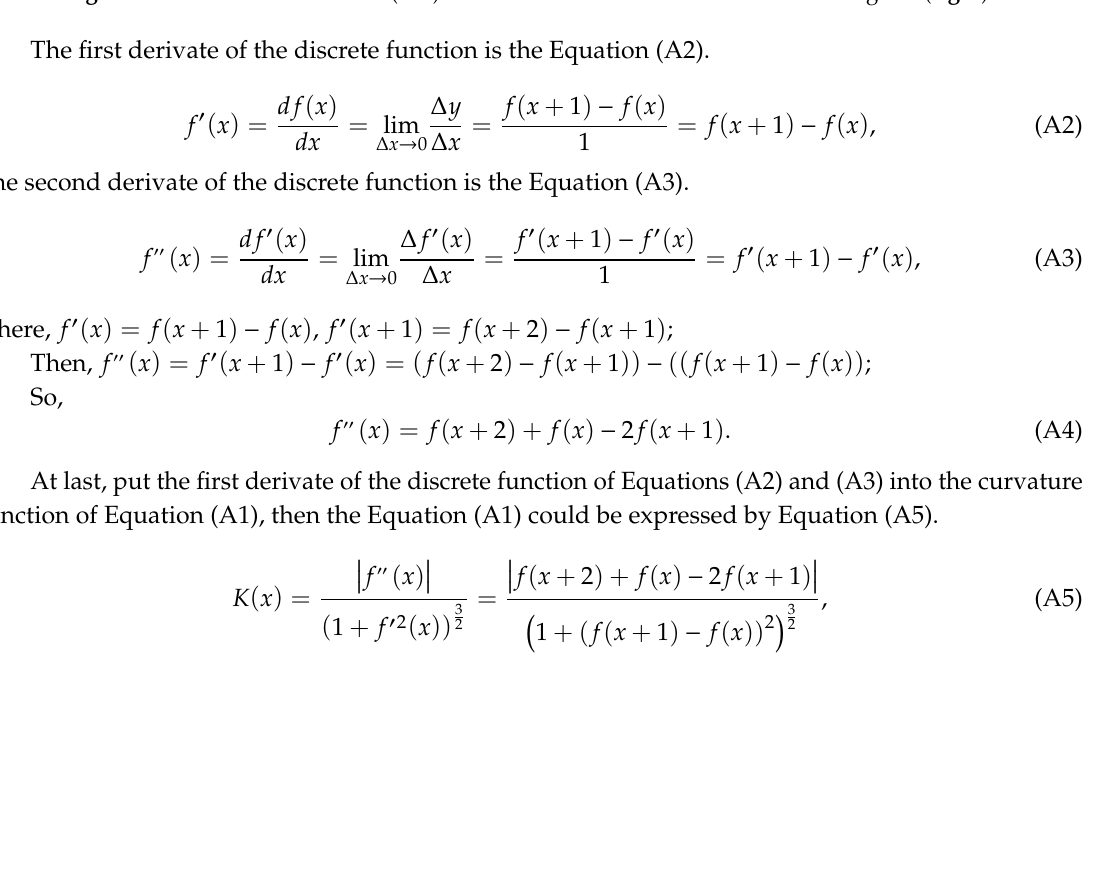
Figure A1. Continuous function ( left ) of variable X and discrete function of histogram ( right